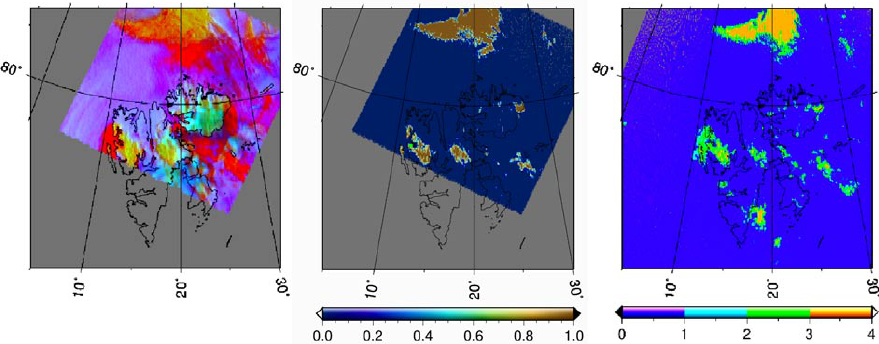
Figure 6. Left panel shows the false colour composite (red is 11µm BT, green is 550nm reflectance, blue is 1.6µm reflectance) of the initial AATSR scene, 11 May 2006, 16h 26min 26s, orbit number 21938; middle panel is the screened AATSR scene, probability of clean snow; right panel is MODIS cloud mask: 1 – cloudy, 2 – probably cloudy, 3 – probably clear, 4 – clear. MODIS scene is for 11 May 2006, 16h 40min.